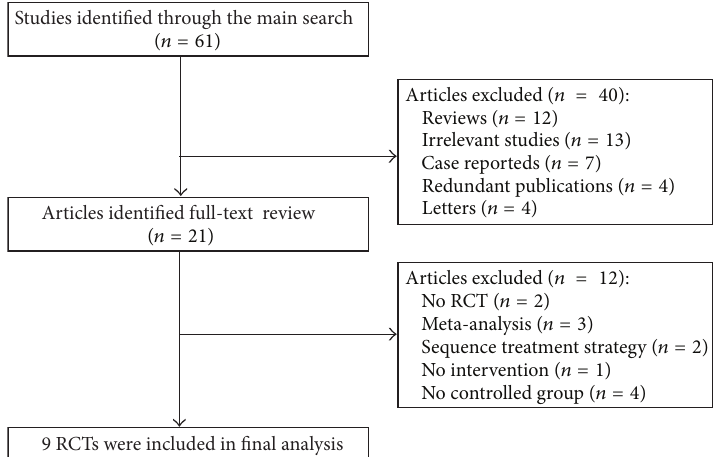
Figure 1: Study selection process. RCTs: randomized controlled